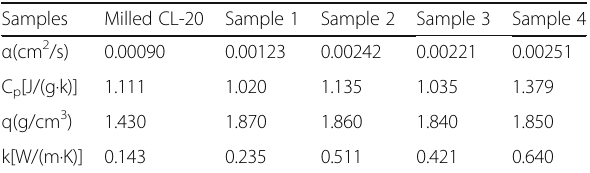
Table 1 Thermal conductivity of samples Samples